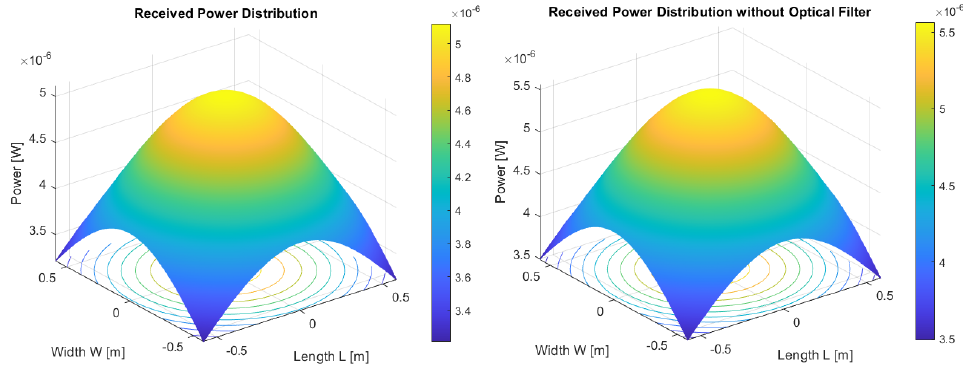
Figure 16. Total received power distribution with optical filter ( left ); Total received power distribution without optical filter ( right ).